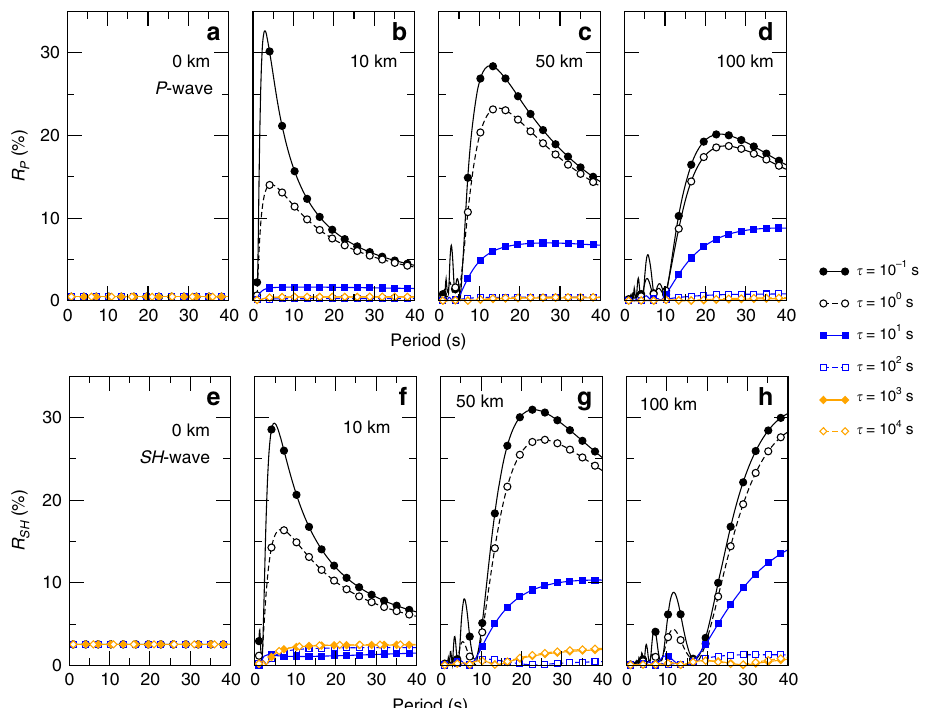
Fig. 4 Seismic re fl ections models. Re fl ection coef fi cients for vertically incident P ( a – d ) and SH ( e – h ) waves on a bridgmanite to post-perovskite interface. The fi gure shows the re fl ection coef fi cients as a function of the wavelength of the incident wave for six Pv-pPv transformation characteristic times τ ranging between 10 (cid:3) 1 and 10 4 s for an in fi nitely sharp boundary ( a , e ), or a Pv-pPv coexistence layer of 10 km ( b , f ), 50 km ( c , g ), or 100 km ( d , h ). For a sharp boundary, re fl ection coef fi cients are 0.5 and 3.5% for P and SH waves, respectively. For thicker Pv-pPv coexistence layers, they can be enhanced or reduced by up to two orders of magnitude depending on transformation kinetics. The wavelength dependence of observable re fl ections (e.g. > 3%) could be used to constrain the thickness of the Pv-pPv coexistence